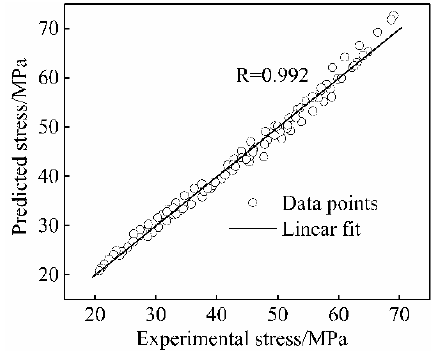
Figure 9. Correlation between experimental and simulated flow stress.